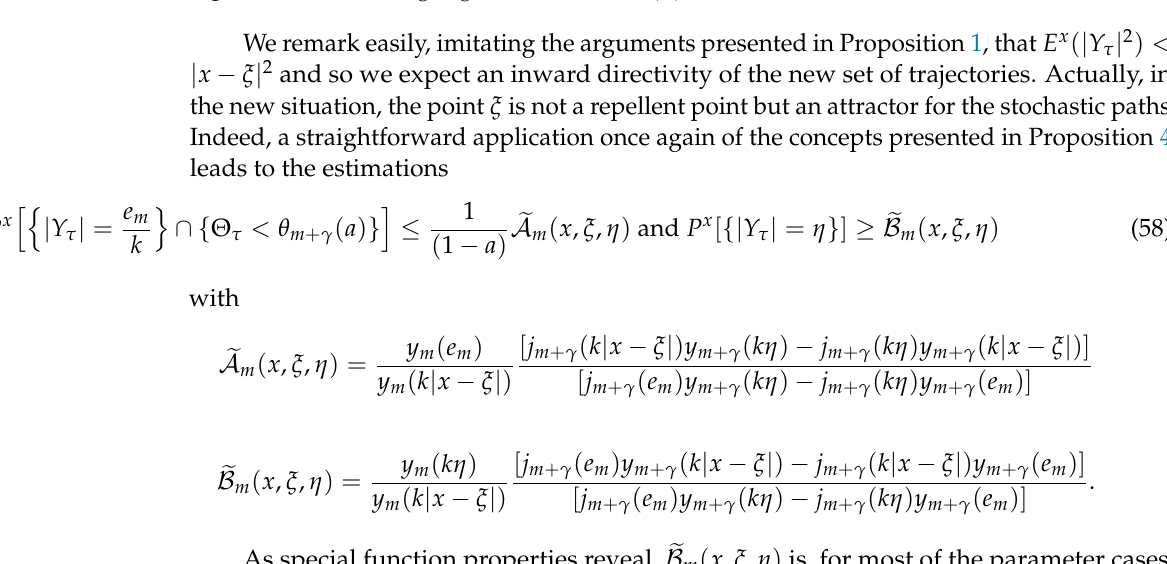
Figure 3. The increasing negative function (cid:101) H m ( λ ) for m =